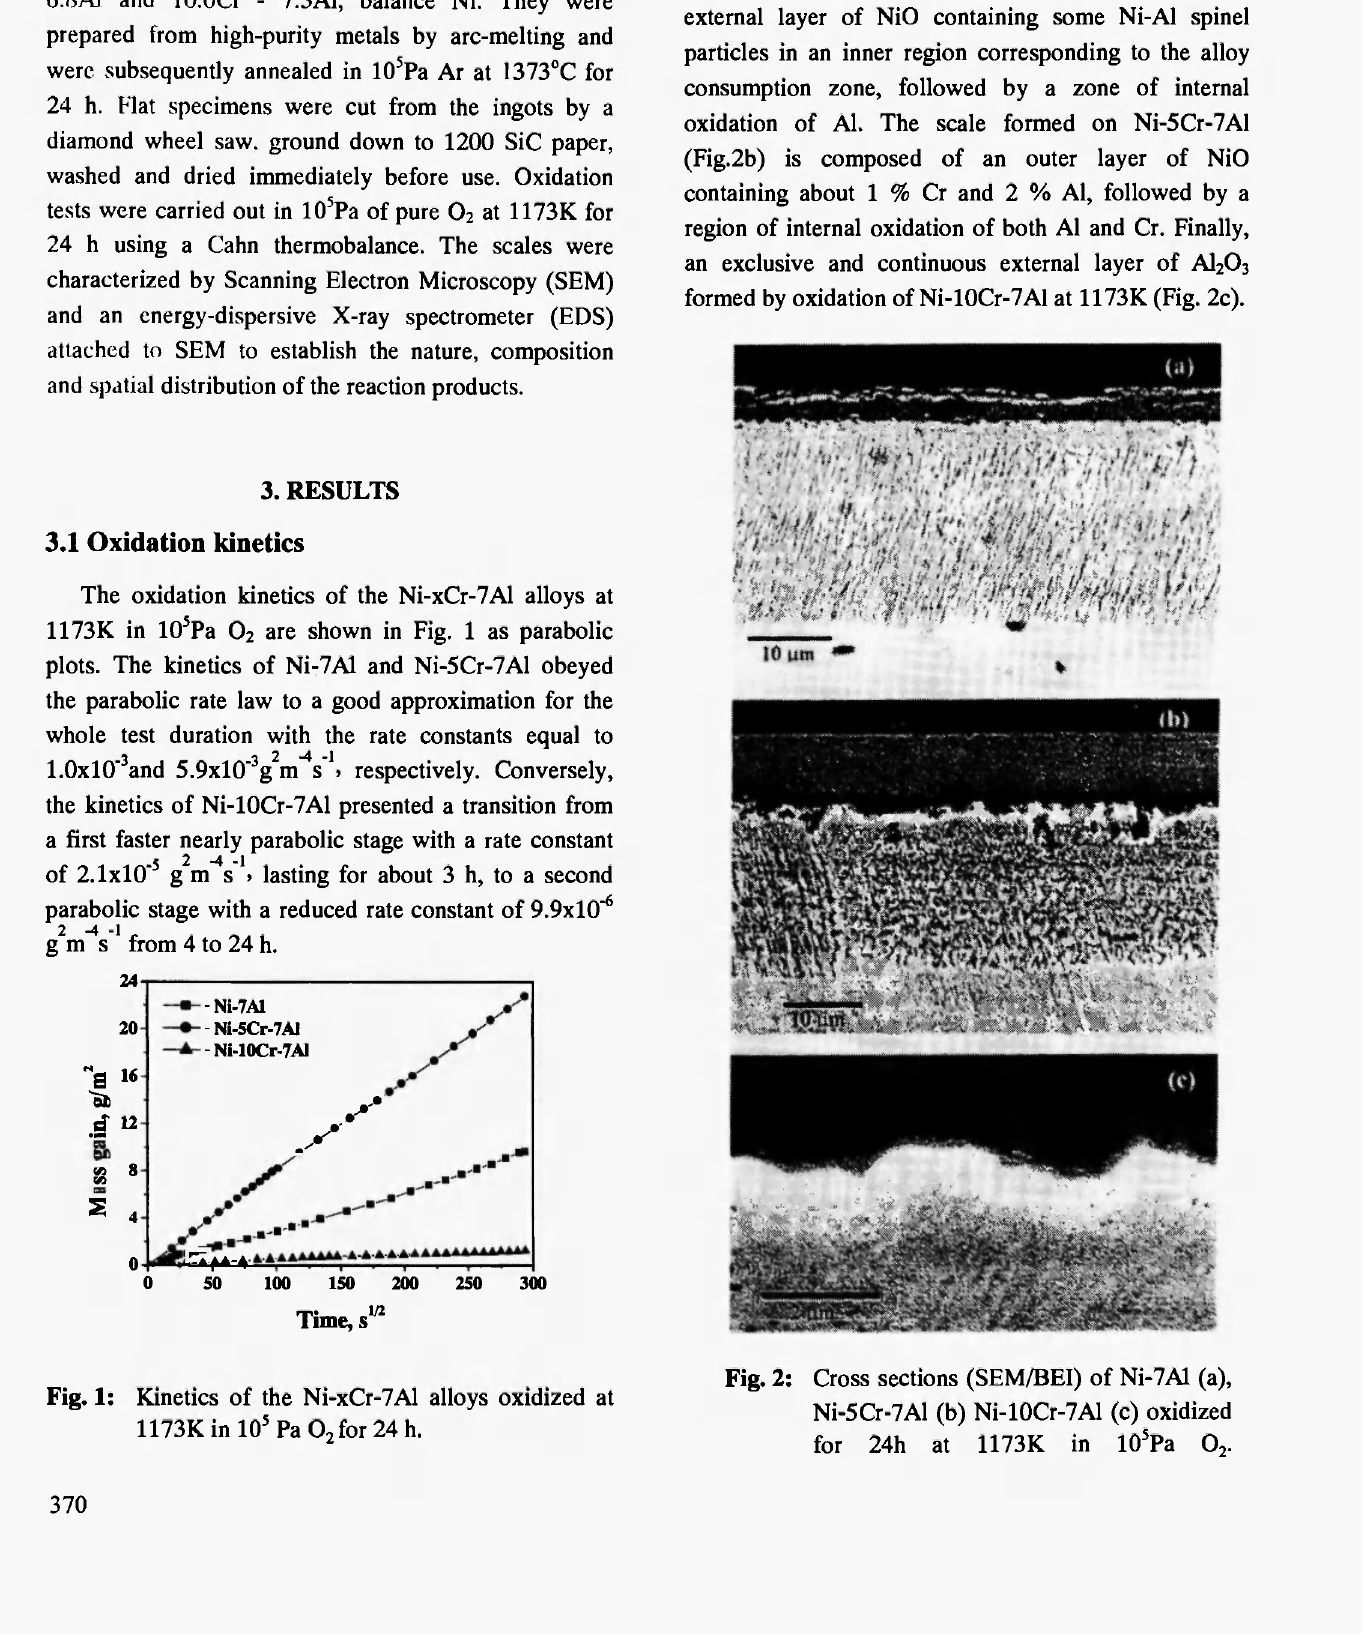
Fig. 2: Cross sections (SEM/BEI) of Ni-7A1